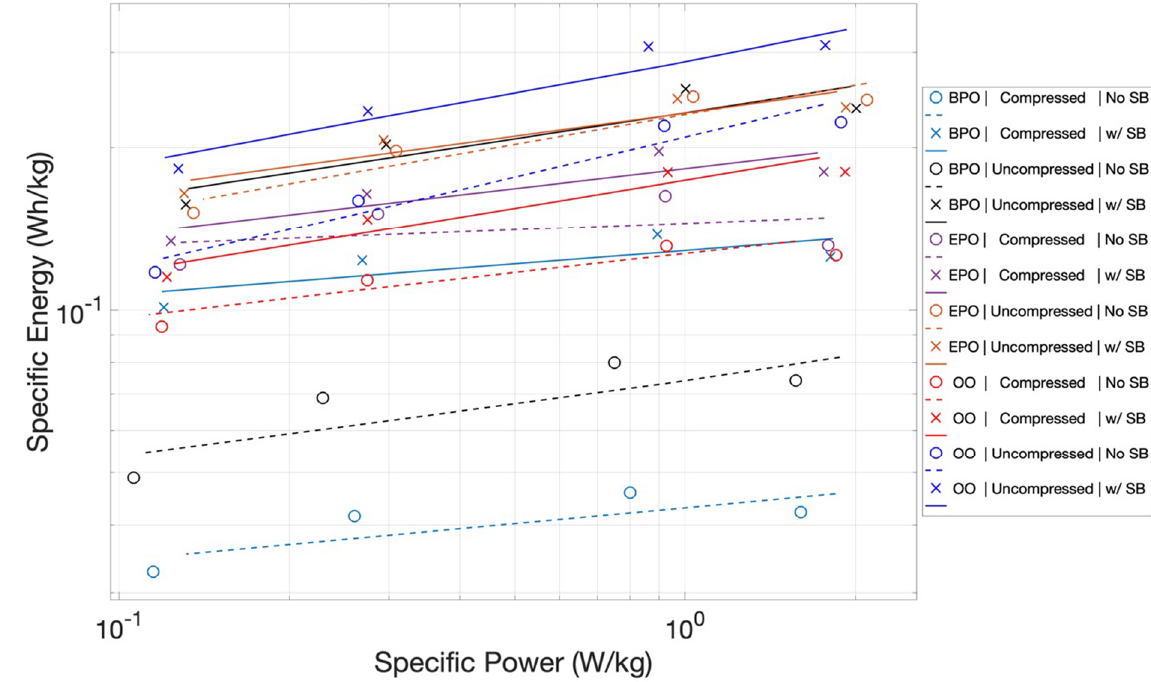
Figure 11. Ragone Plot . These plots show the same configuration and salt bridge impacts observed in the specific energy and power plots. Also notable is that the plots are all positive slopes, whereas, in general, for capacitors, the slopes on a Ragone chart are negative.